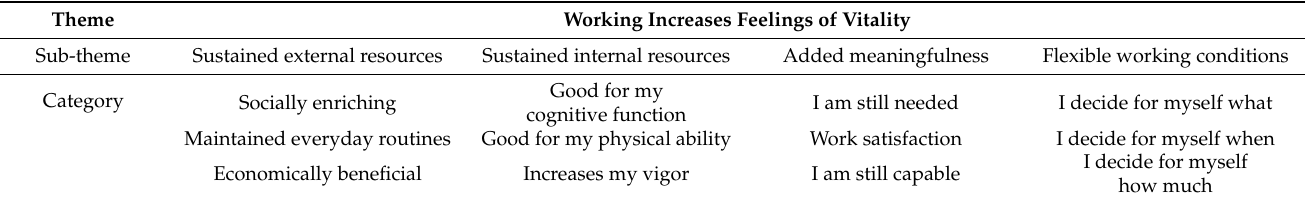
Table 2. Overview of findings: theme, subthemes, and